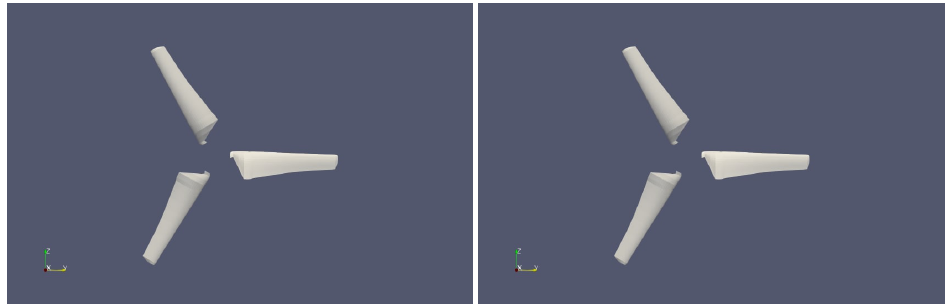
Figure 7. Same legend as for previous figure but without a hub.